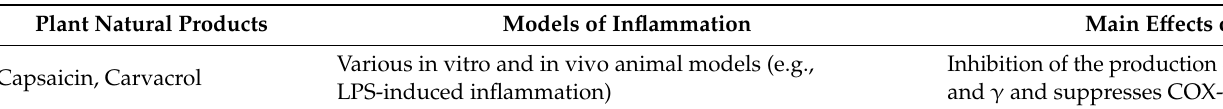
Table 1. Natural polyphenols and their anti-inflammatory activity.